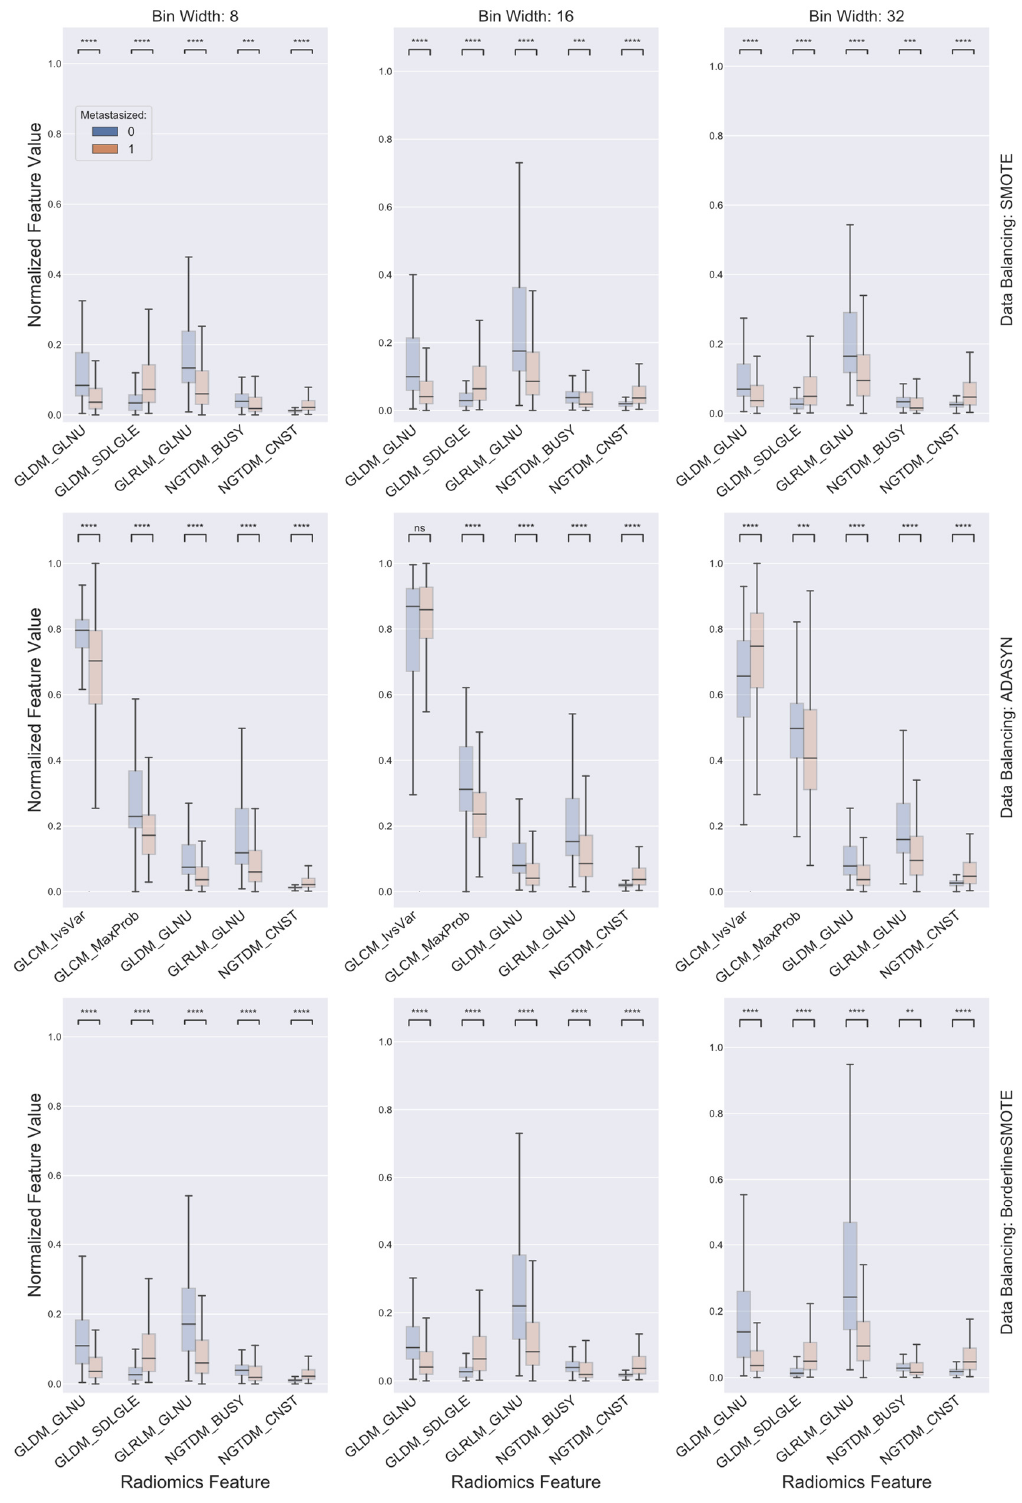
Figure 4. Boxplots comparing the top five consensus radiomics features selected for each of the data balancing algorithms between cohorts with (in red) and without (in blue) distant metastasis. The radiomics feature values were normalized to between 0 and 1 for easier visual display. On each box, the central mark indicates the median, and the top and bottom edges of the box indicate the 25th and 75th percentiles, respectively. For each box pair comparison: NS, not significant at level of 0.005; *, p < 0.005; **, p < 0.001; ***, p < 0.0001; and ****, p < 0.00001. All p values were corrected for multiple testing by the Bonferroni-Holm method.